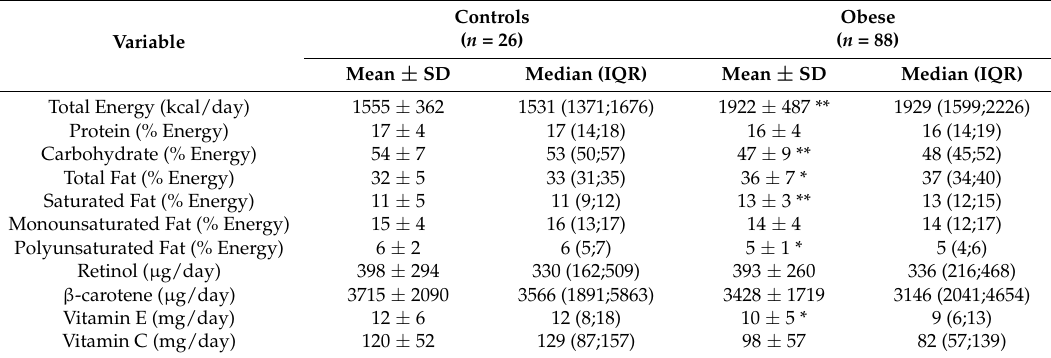
Table 2. Dietary intake of macronutrients and selected vitamins in obese and non-obese (control) women.